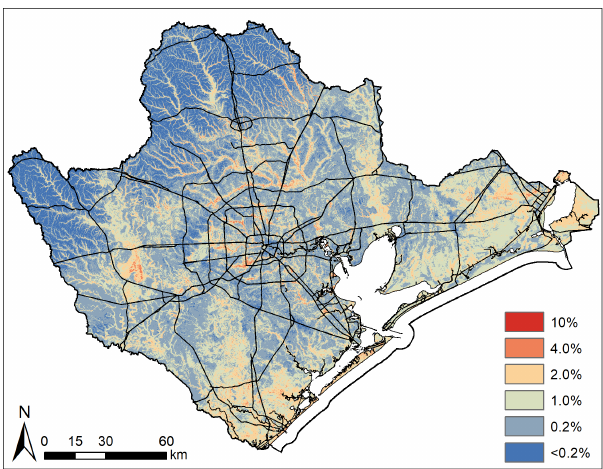
Figure 6. Continuous flood hazard map for the pilot study area based on model output. Road layers originated from the US Cen- sus